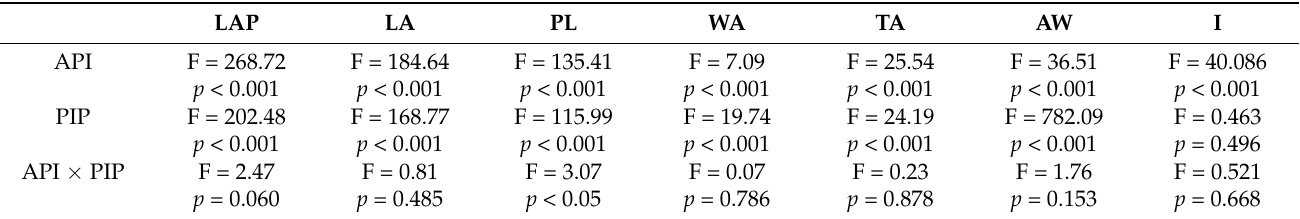
Table 2. Effect of the main factors and their interactions on achene morphometric traits. Results of the two-way analysis of variance (ANOVA). API—the achene position within the infructescence; PIP—the position of the infructescence on the plant; LAP—length of the achene with pappus; LA—length of the achene without pappus; PL—pappus length; WA—width of the achene; TA—thickness of the achene; AW—the achene weight; I—shape index.